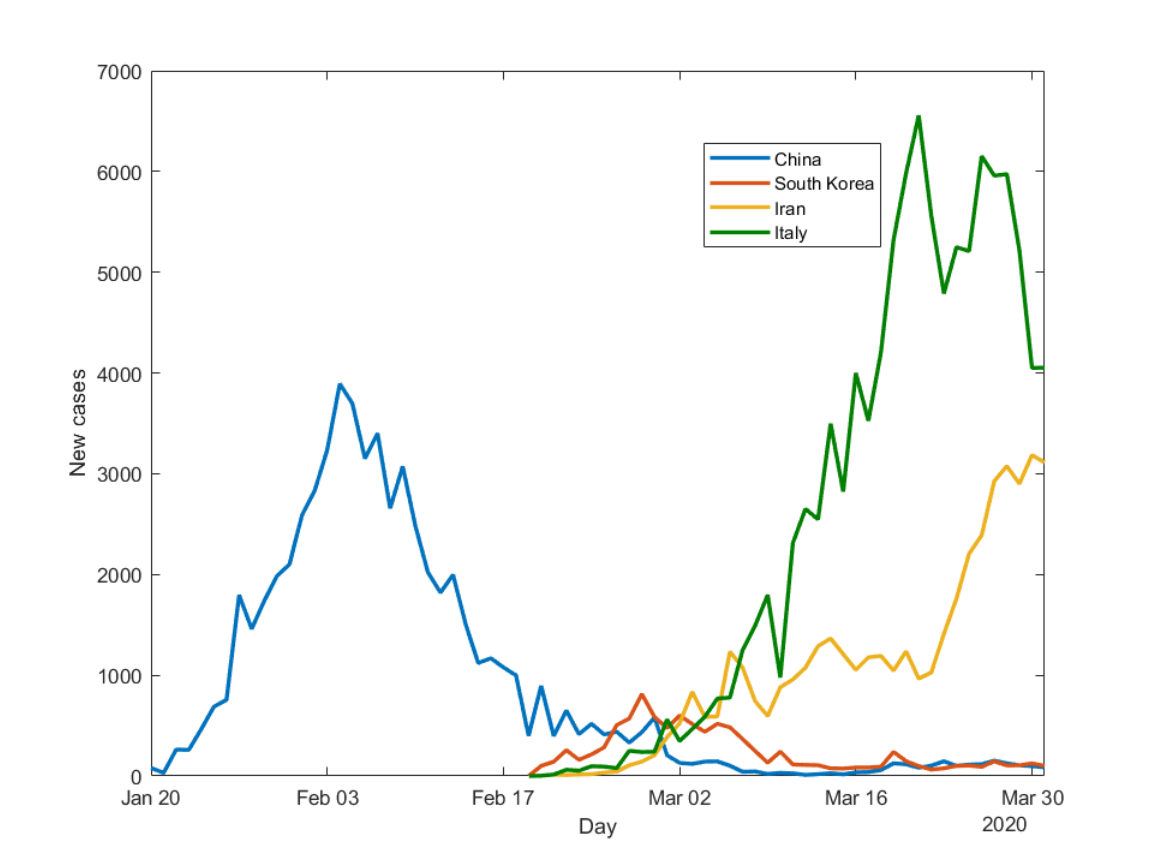
Figure 1. Observed infection counts.